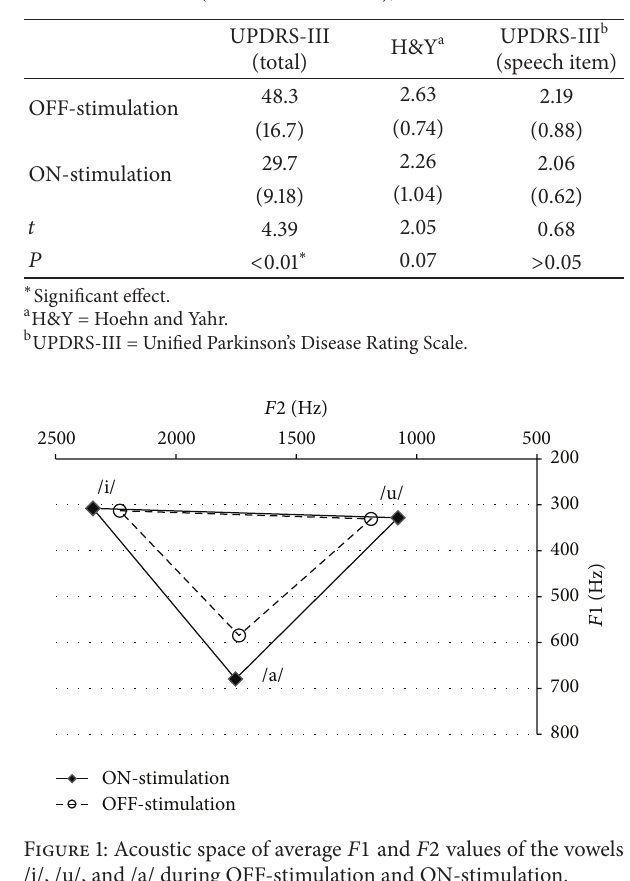
Table 3: Scores on motor subscale of the UPDRS (no symptoms = 0), Hoehn and Yahr (H&Y, mild = 1) staging during ON- and OFF- stimulation: means (standard deviations), 𝑡 and P values.